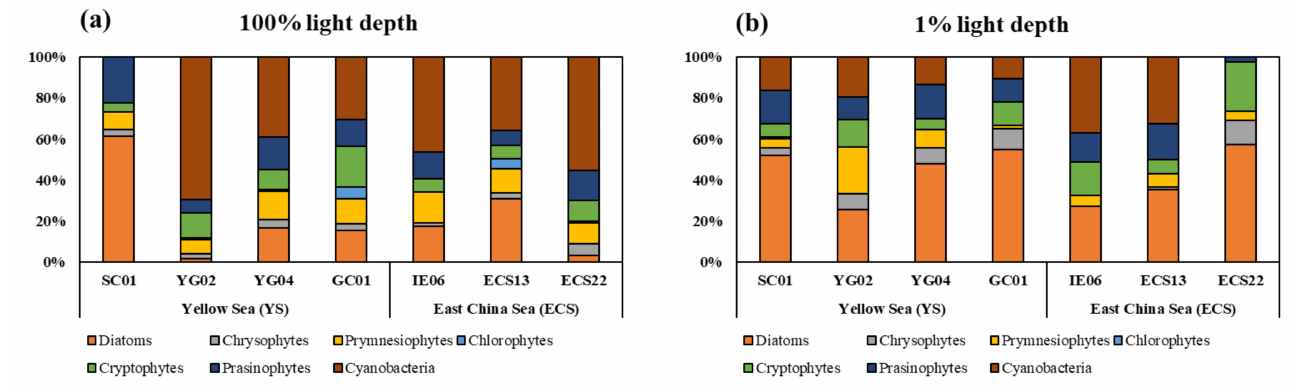
Figure 4. Relative contributions of different phytoplankton groups to total phytoplankton biomass at ( a ) 100% and ( b ) 1% light depths in the YS and ECS during the study